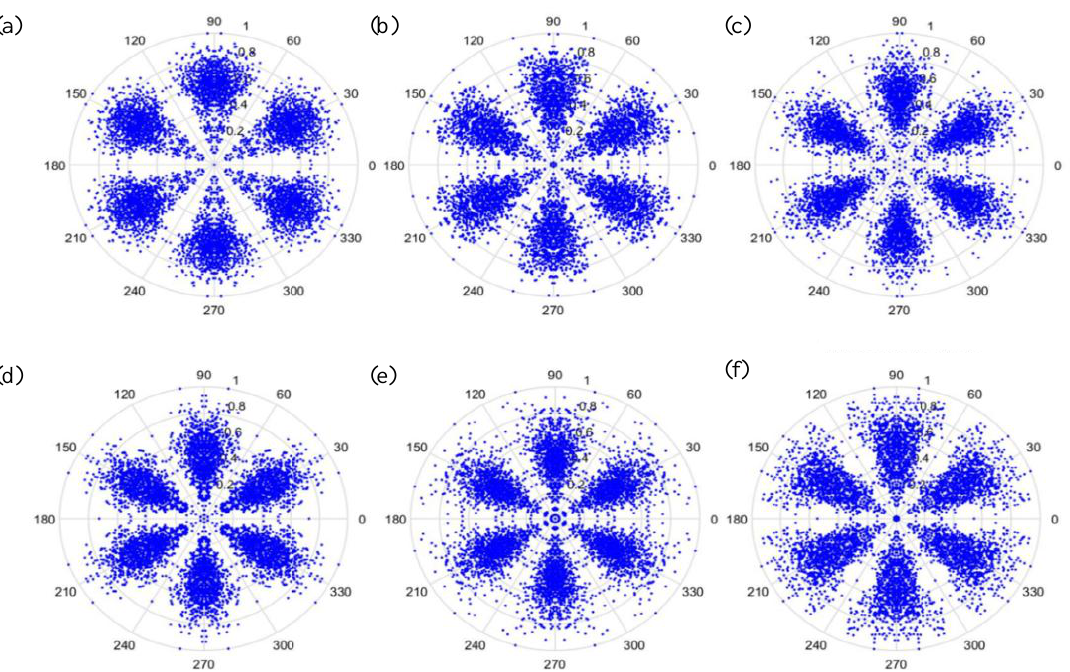
Figure 7. Results when t = 1 and sampling is at 1000 Hz / 1000 rpm. ( a ) Normal, ( b ) motor platform with one eccentric screw, ( c ) motor platform with two eccentric screws, ( d ) sanded ball bearings, ( e ) insufficient lubrication, and ( f ) worn ball bearings.